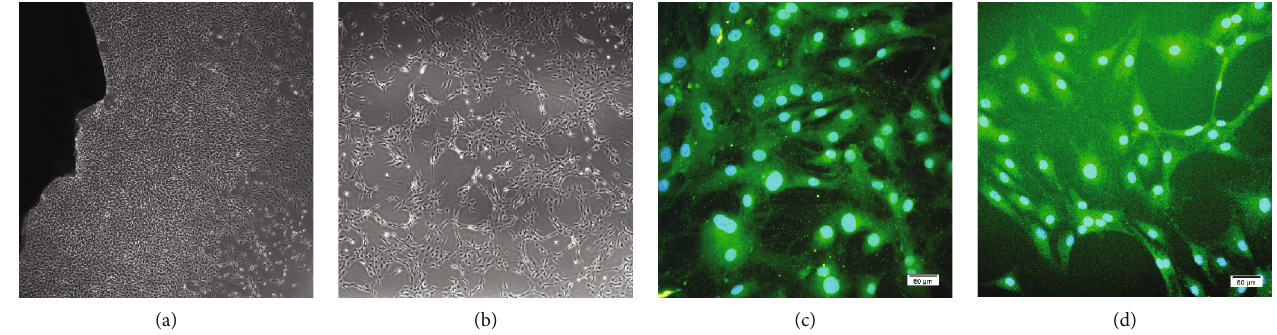
Figure 2: Characterization of ECs. (a) Primary culture of ECs. The black opaque area is the blood vessel fragments. (b) Subculture of ECs (P2). (c) ECs positively expressed vWF by immuno fl uorescence. (d) ECs positively expressed CD31 by immuno fl